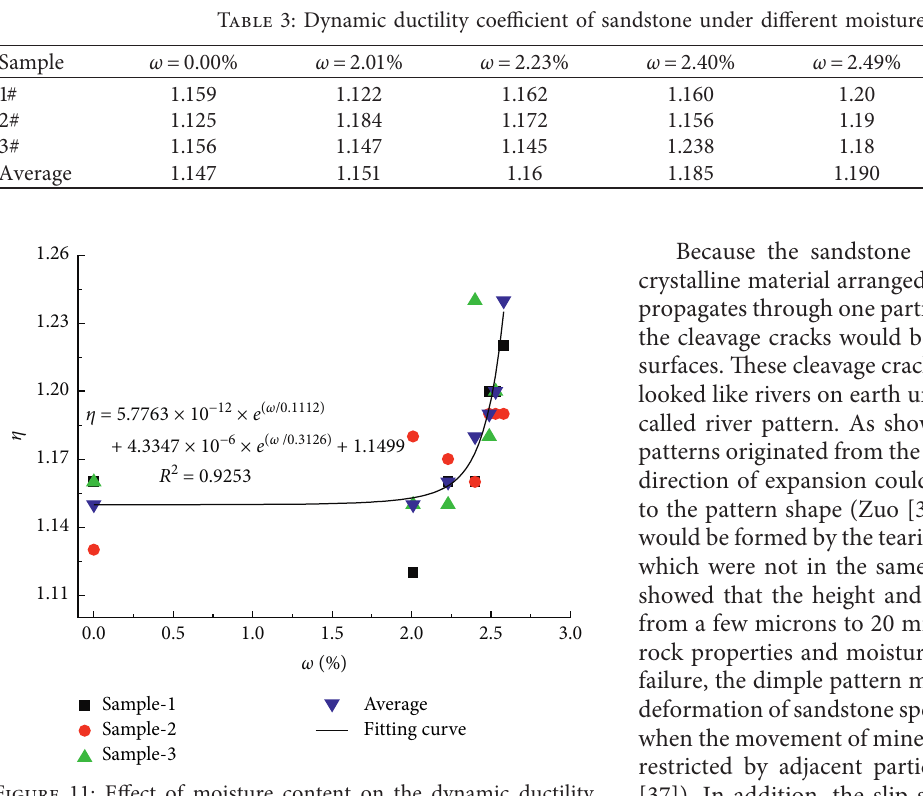
Figure 11: Effect of moisture content on the dynamic ductility coefficient.